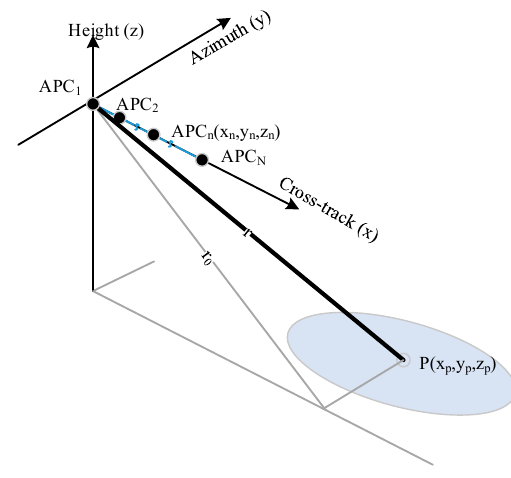
Figure 1. TomoSAR acquisition geometry.